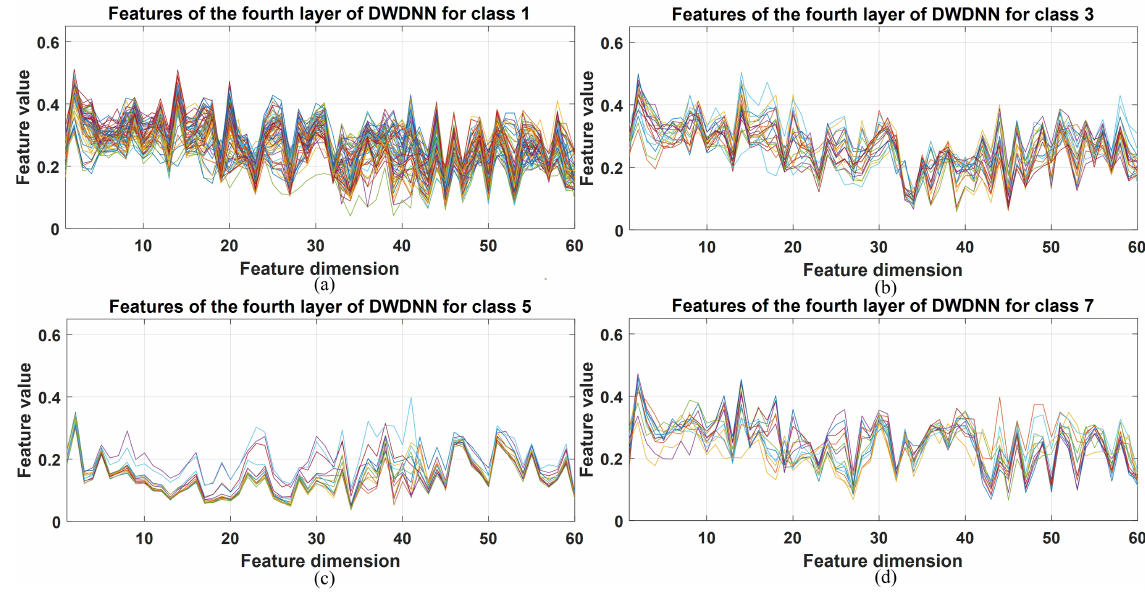
Figure 9. Stacked extracted features of the training instances from the last transform kernel layers of the DWDNN (10 EWSWS networks) with the Pavia University dataset. ( a ) Extracted features for class 1. ( b ) Extracted features for class 3. ( c ) Extracted features for class 5. ( d ) Extracted features for class